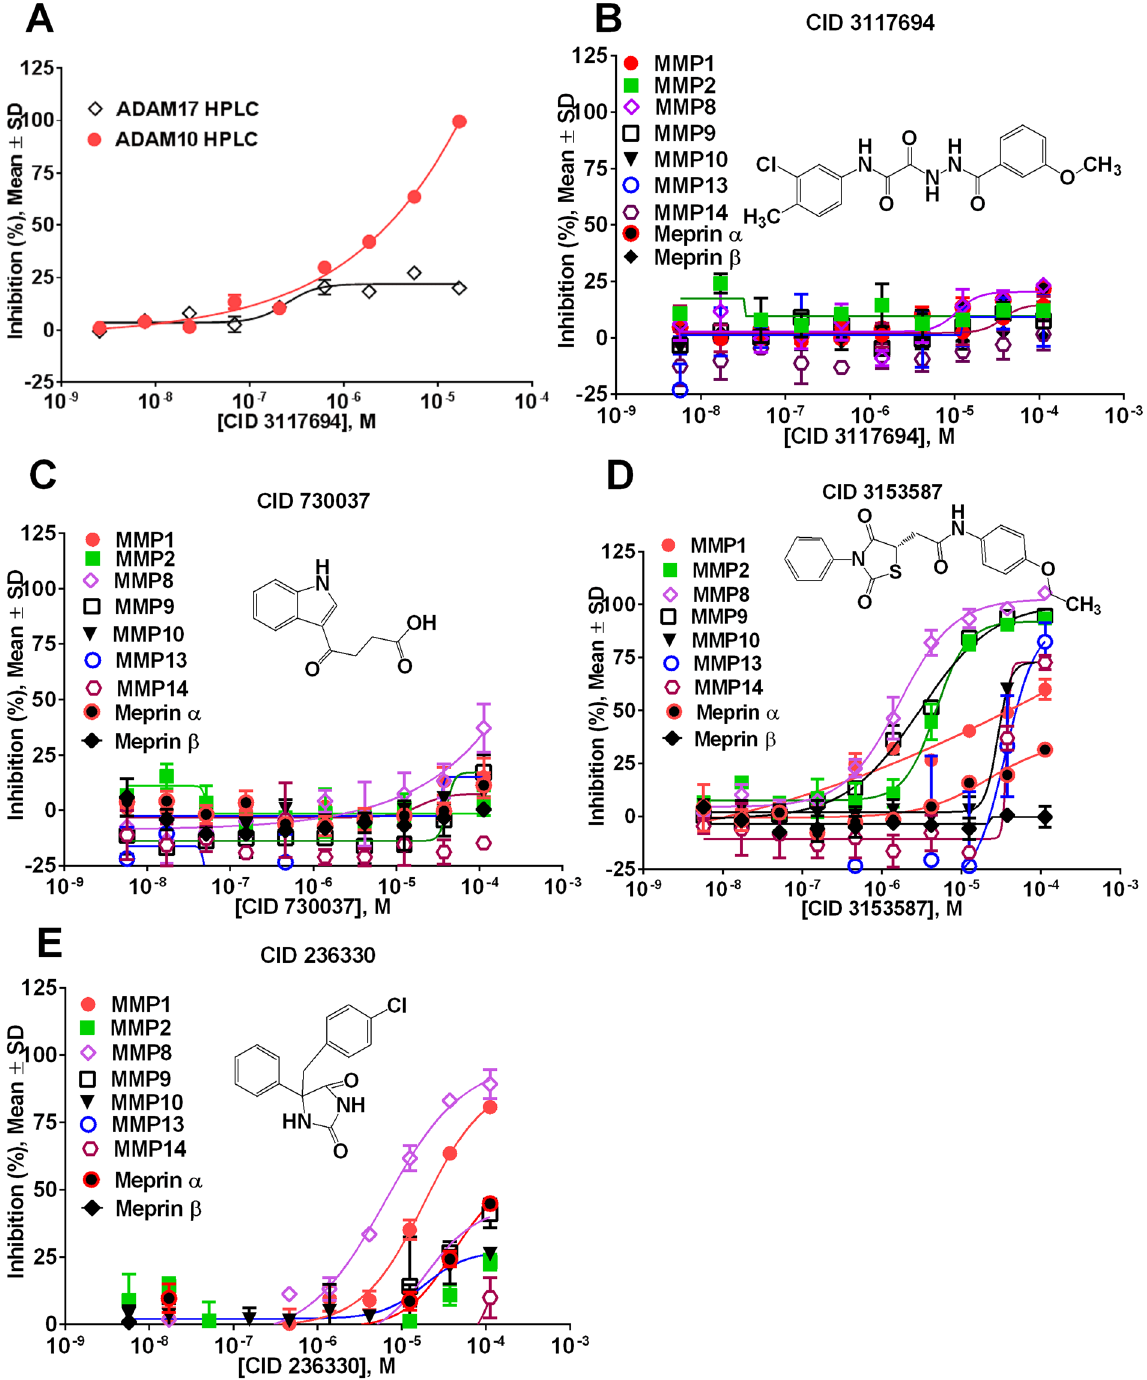
Figure 2. Results of dose response study of primary HTS hits against the panel of metzincins. ( A ) HPLC- based assays of CID 3117694 against ADAM10 and 17 using glycosylated substrate. ( B ) Screening of CID 3117694 against a panel of metzincins. ( C ) Screening of CID 730037 against a panel of metzincins. ( D ) Screening of CID 3153587 against a panel of metzincins. ( E ) Screening of CID 236330 against a panel of